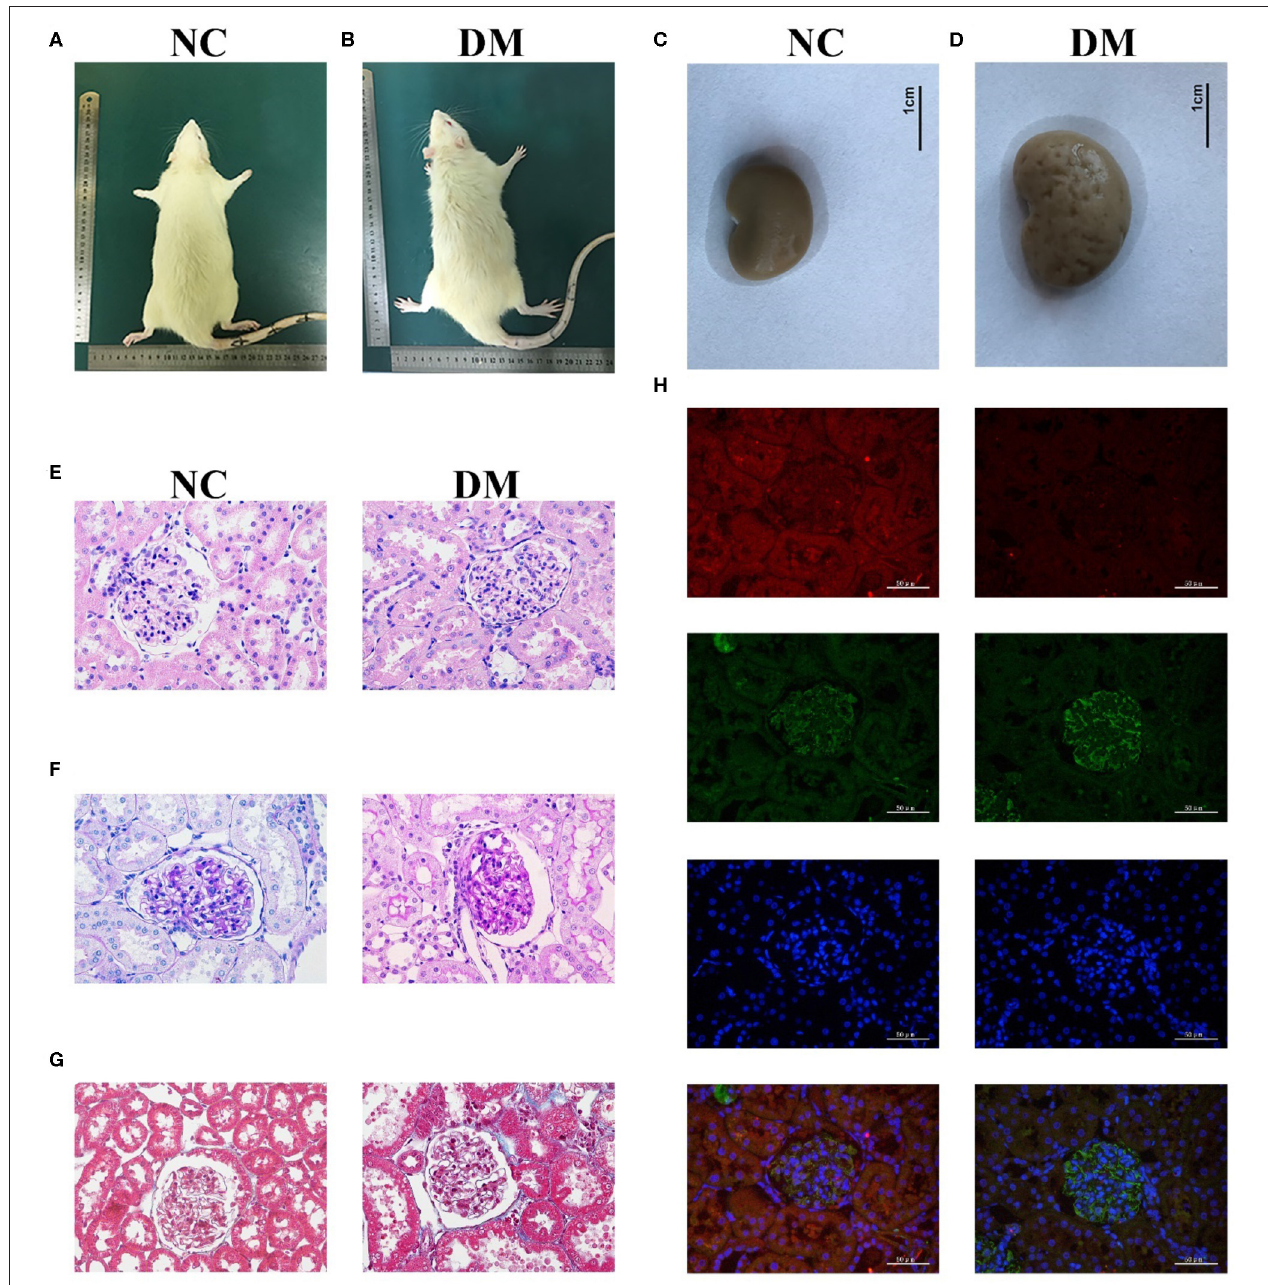
FIGURE 2 | Renal histology in diabetic rats. (A,B) photos of rats, (C,D) gross specimen, (E) HE stain, (F) PAS stain, (G) Masson stain, (H) Immunofluorescence double staining of VASH-1 (red), VEGF (green), DAPI (blue), and merge.